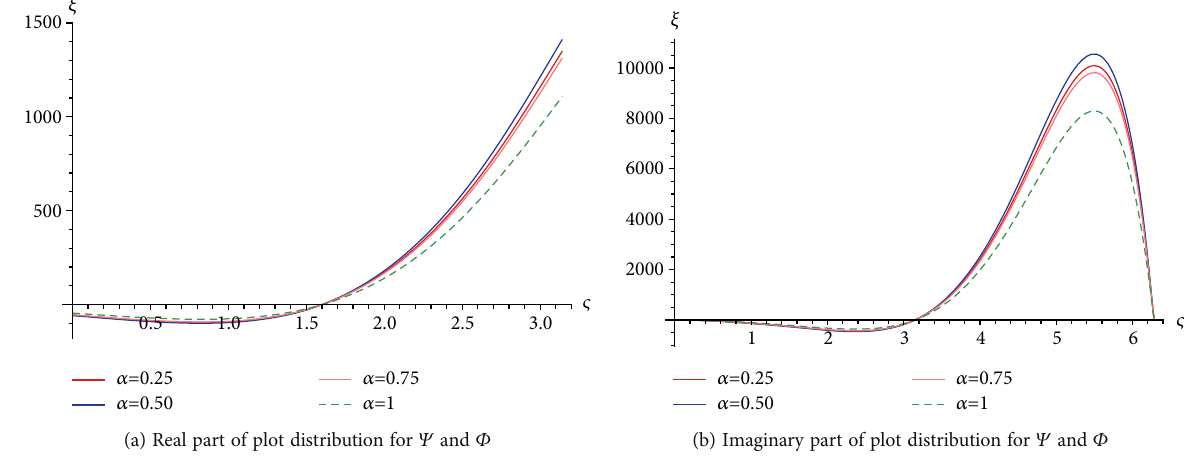
(b) Imaginary part of plot distribution for Ψ and Φ Figure 4: Plot distribution for di ff erent values of α at ξ = 1